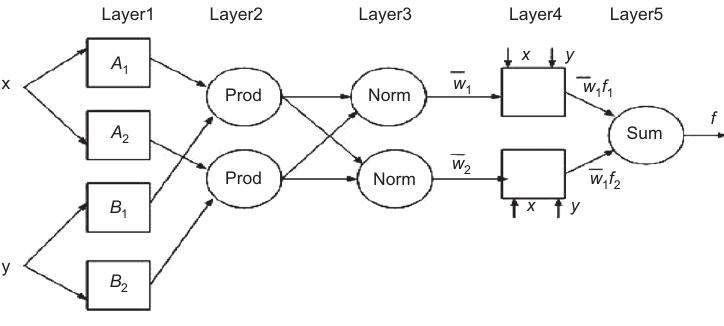
Figure 6. Architecture of